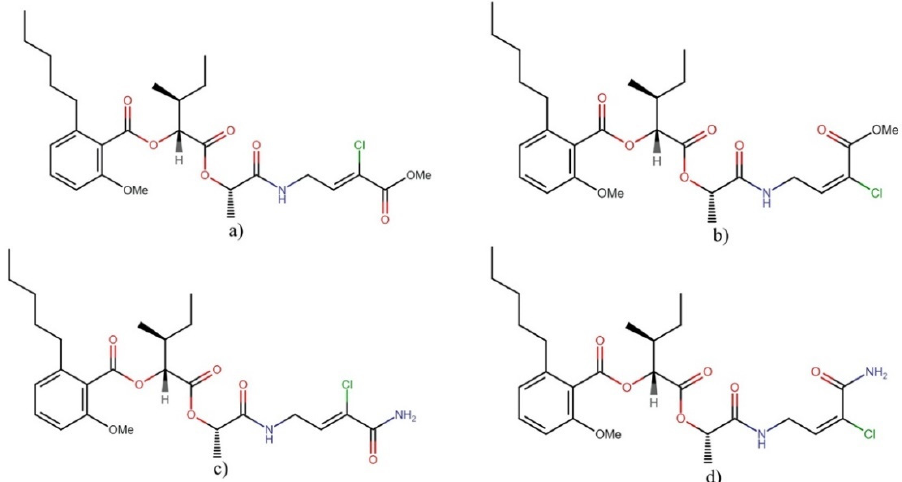
Figure 6. Chemical structures of anaenamides: ( a ) anaenamide A, ( b ) anaenamide B, ( c ) anaenamide C, and ( d ) anaenamide D.